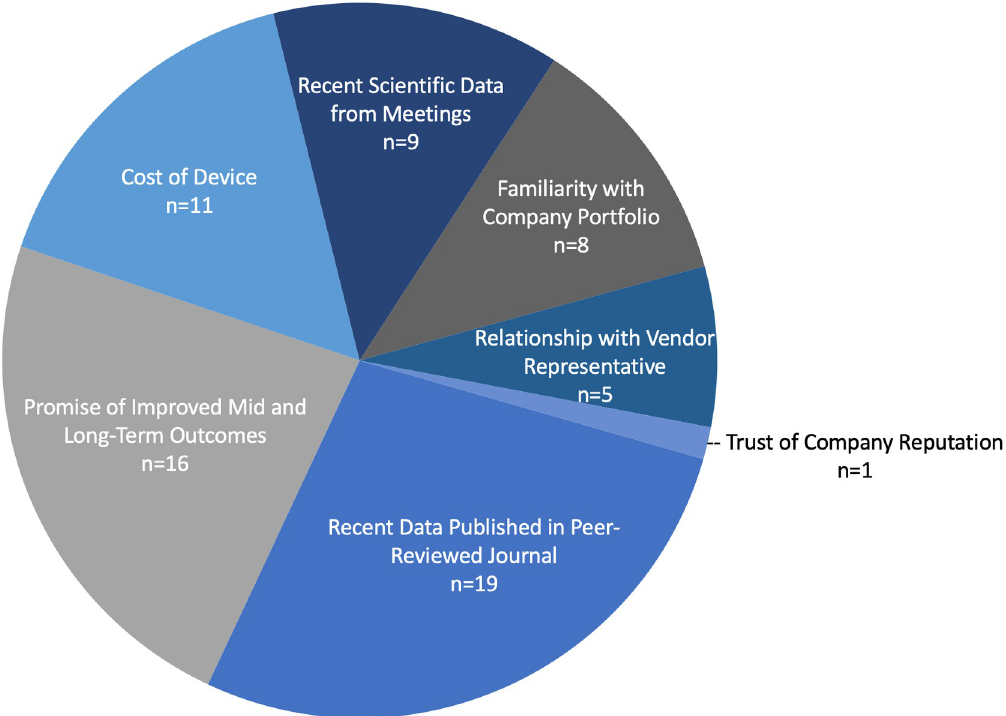
Fig 5. Importance of decision factors in product selection. Importance of decision factors in product selection for arthroplasty